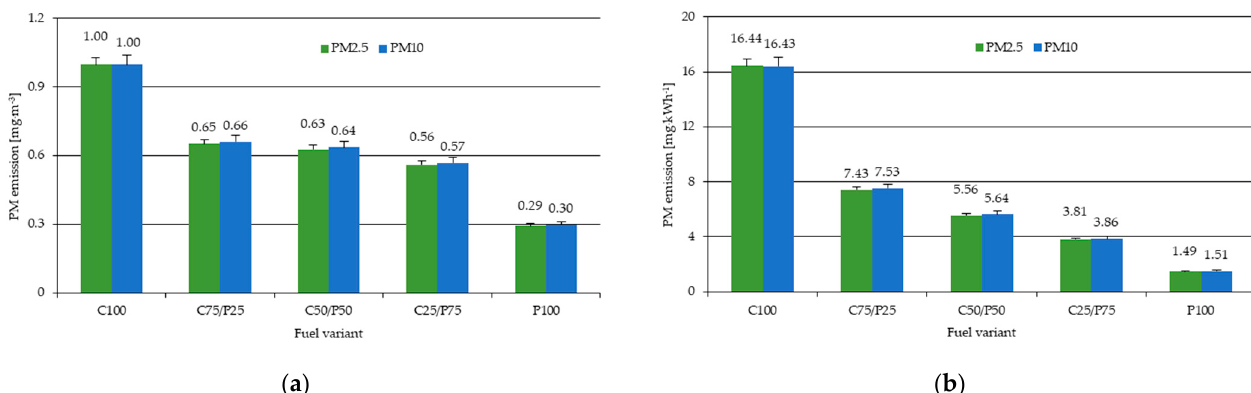
Figure 9. PM emission per ( a ) 1 m 3 exhaust gas; ( b ) 1 kWh thermal energy.